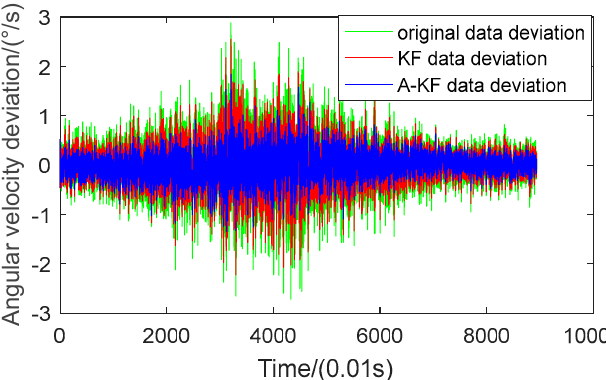
Figure 7. Angular rate error comparisons between the KF method and the A-KF method.